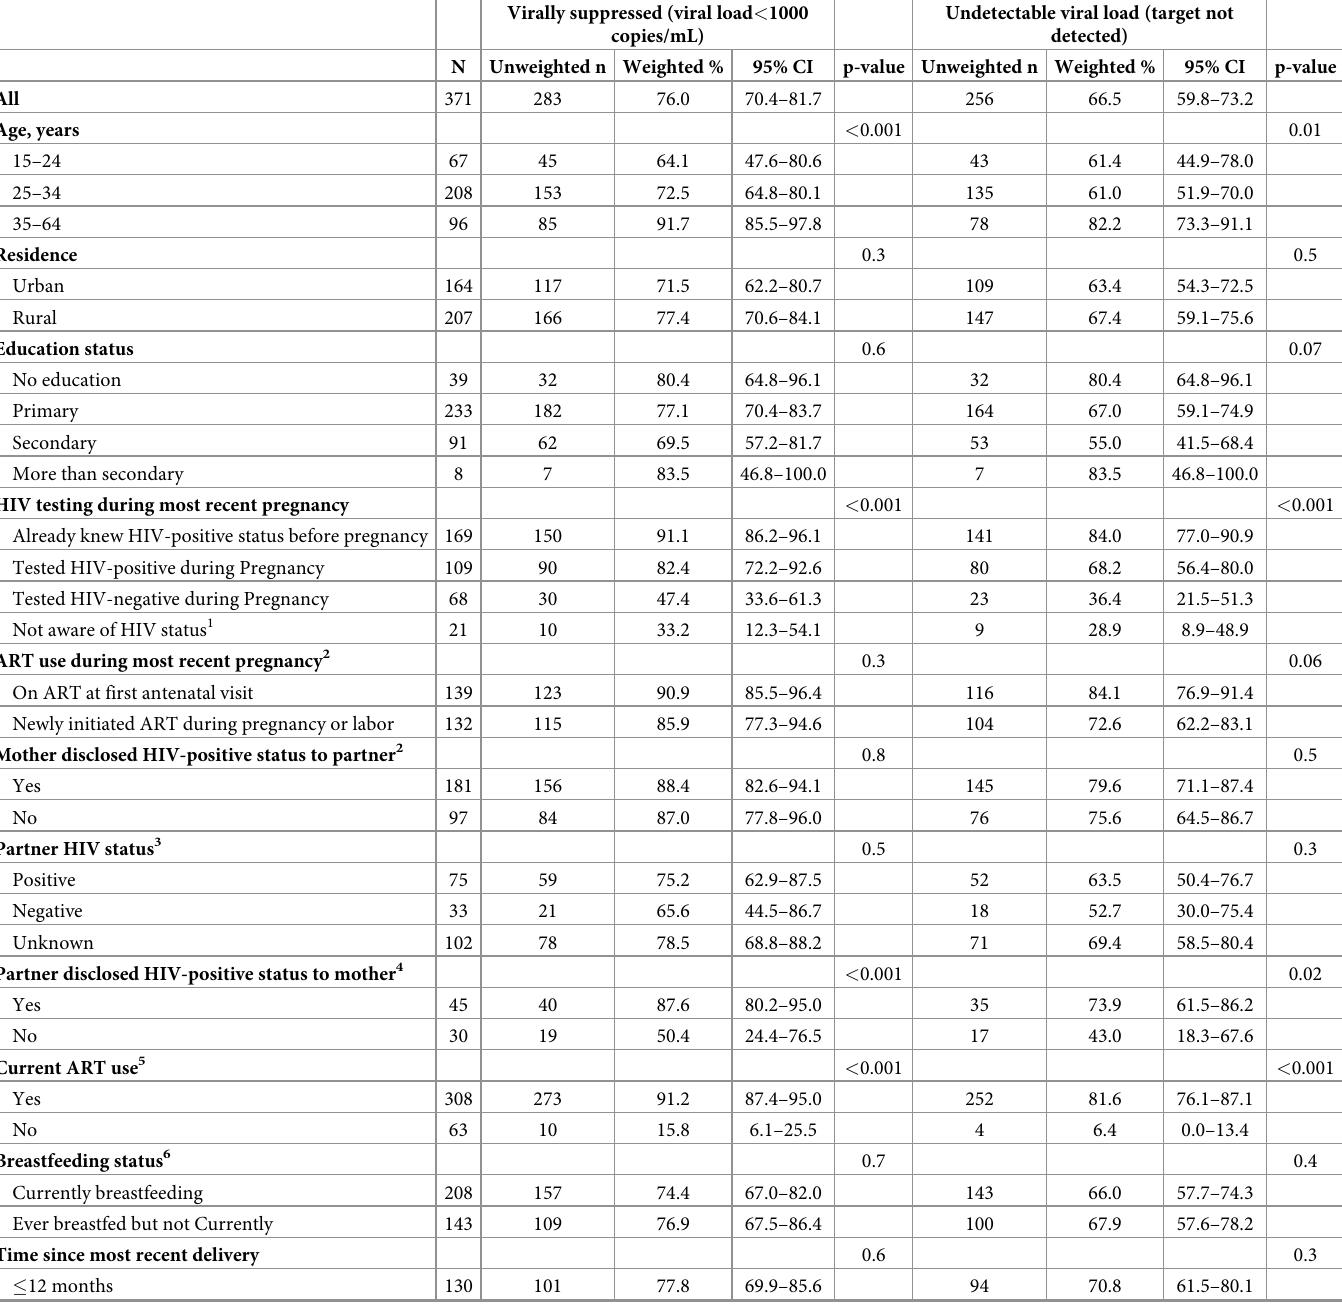
Table 2. Viral load suppression among HIV-positive women aged 15–64 years who had a live birth in the 3 years before the 2015–2016 Malawi Population-based HIV Impact Assessment (MPHIA) survey (N = 371). Virally suppressed (viral load < 1000